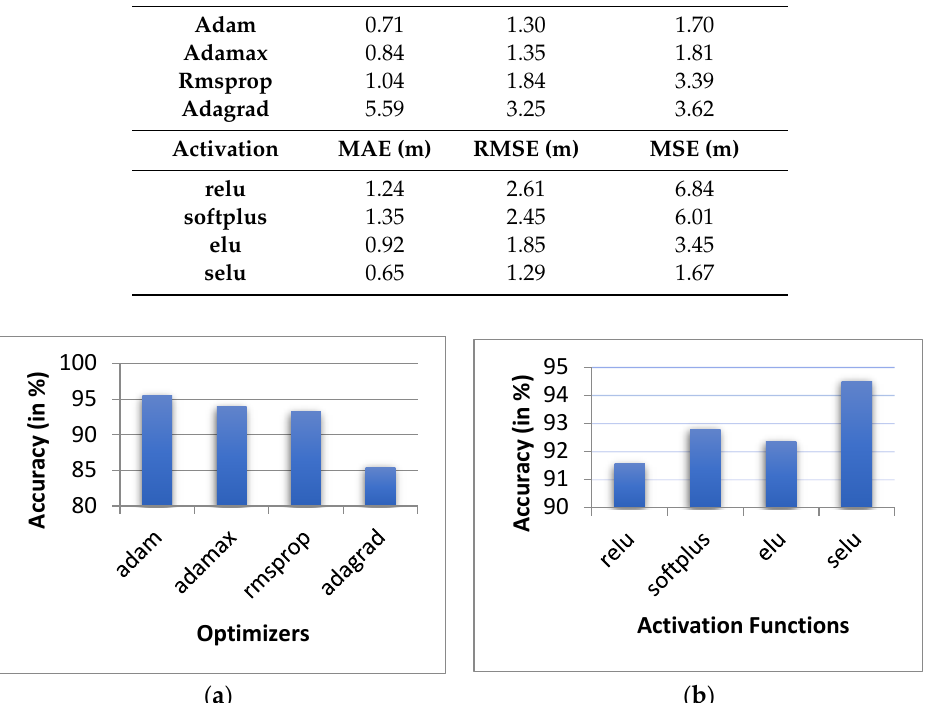
Figure 10. Prediction error with: ( a ) different optimizers and ( b ) different activation functions.